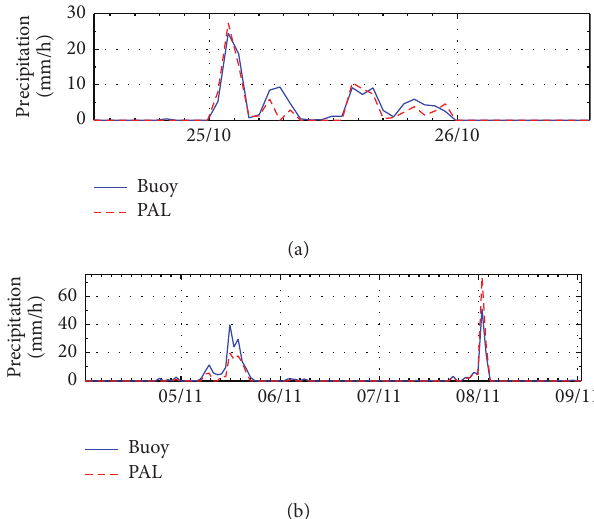
Figure 9: Buoy and PAL precipitation time series of the two floods. Rainfall rate comparison between buoy measurements and Passive Aquatic Listener estimates during two major flood events occurred on (a) October 25, 2011, in La Spezia and on (b) November 4–9, 2011, in